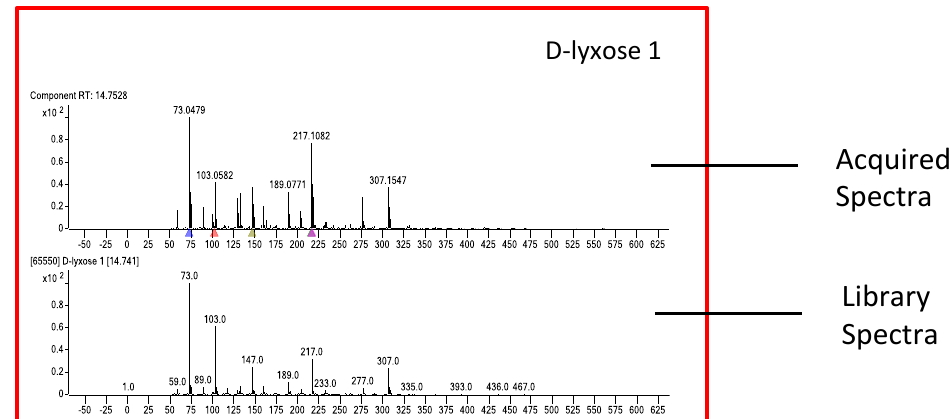
Figure 8. GC/Q-TOF spectral search results.